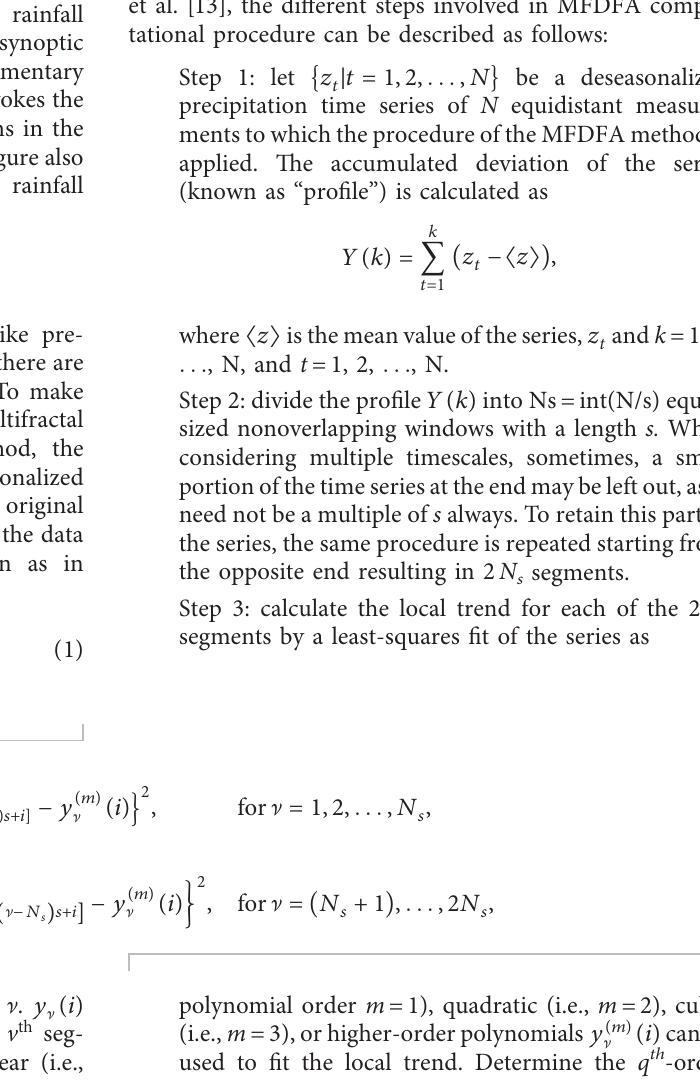
Kandi Co: Cotonou; Bo: Bohicon; Sa: Save; Pa: Parakou; Na: Natitingou; Ka: Kandi. Min and max have units corresponding to the units of the